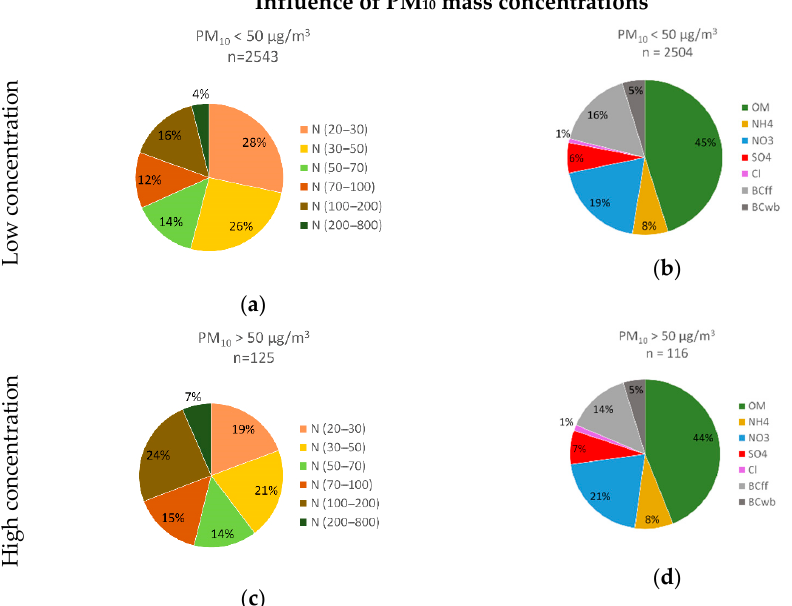
Figure 8. Particle size contribution ( a ) and chemical composition ( b ) for low PM 10 mass concentra- Figure 8 tions and particle size contribution ( c ) and chemical composition ( d ) for high PM 10 mass concentra- tions at the background site.